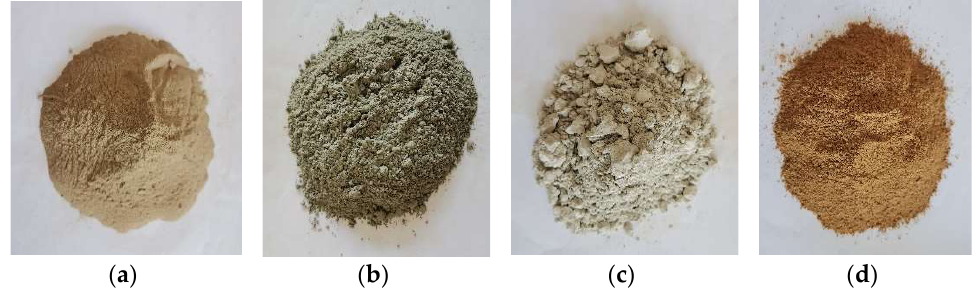
Figure 1. Materials: ( a ) silt, ( b ) cement, ( c ) lime, ( d ) titanium gypsum.